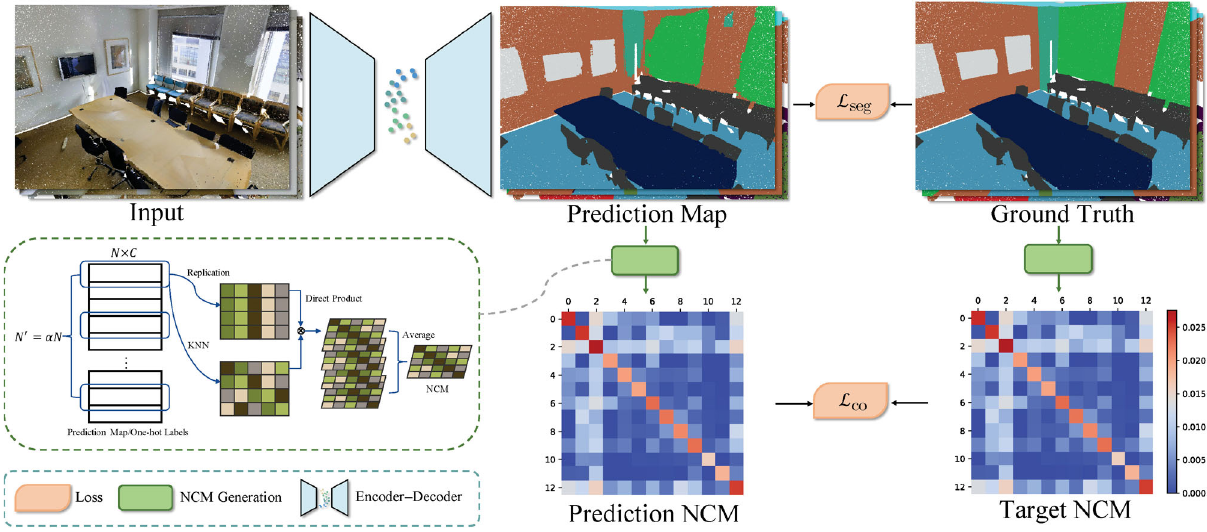
Fig. 2 Architecture of our proposed method. An encoder–decoder network is used to produce the prediction map. Then, prediction NCM and target NCM are generated from the prediction map and ground truth respectively. The KL divergence of these two distributions is minimized to learn local co-occurrence relationships in the real